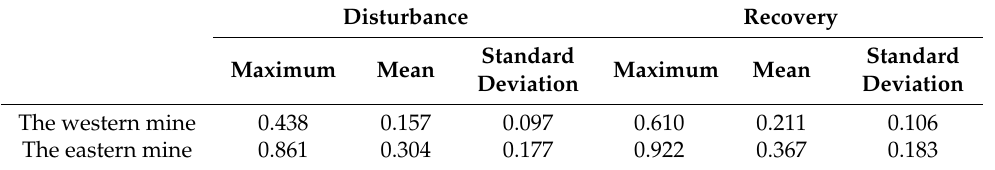
Table 3. Magnitude of disturbance and recovery.